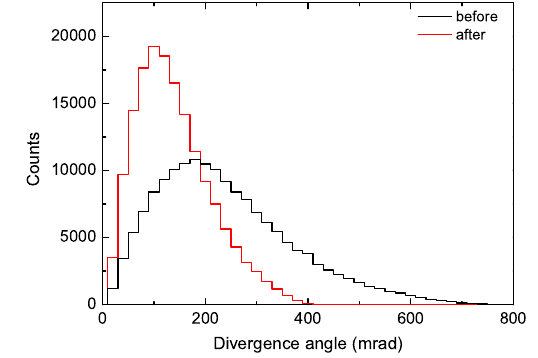
FIG. 16. Divergence angle distributions before and after the adiabatic matching section in the case of 14 T capture field.